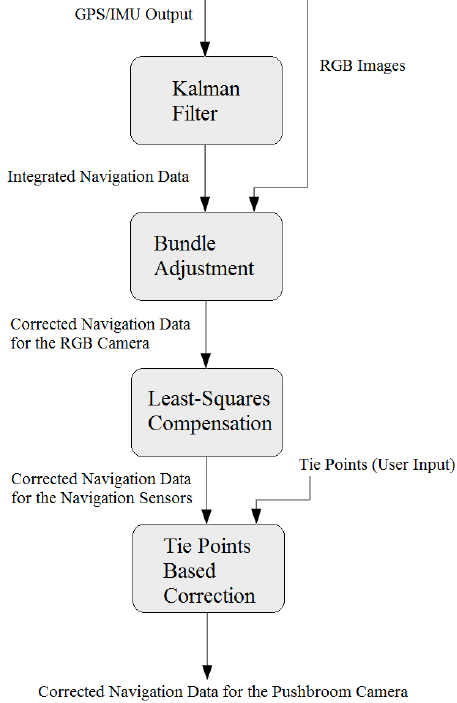
Figure 4. flowgram of our approach.